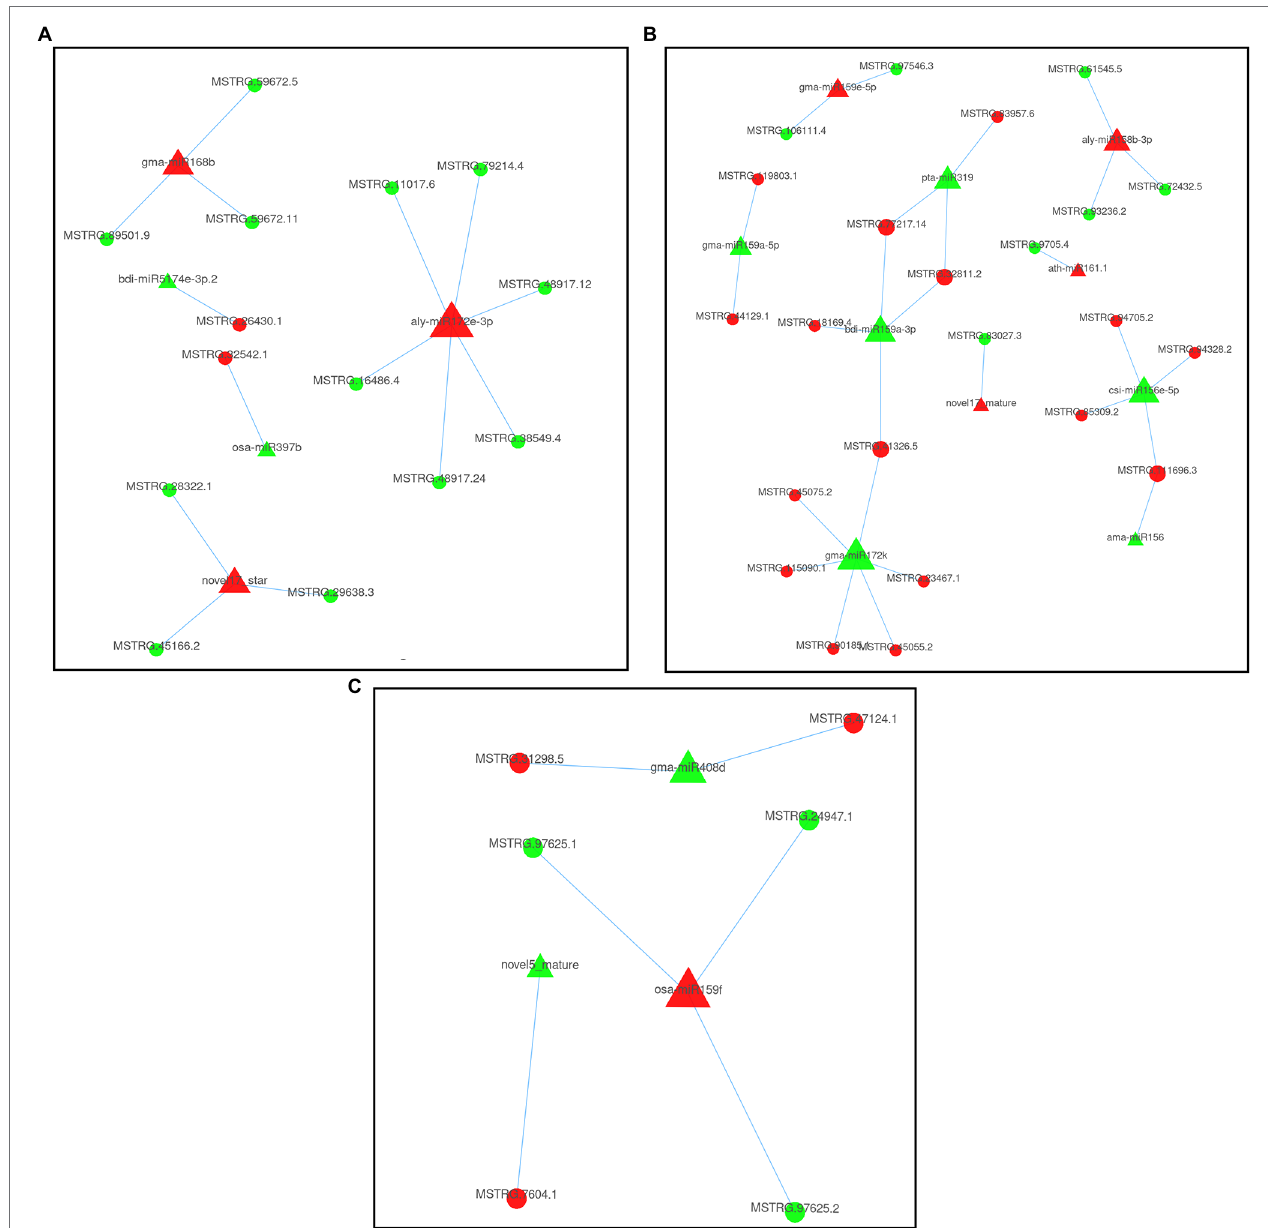
FIGURE 4 | Potential miRNA and mRNA regulatory network of patchouli in response to continuous cropping obstacle. (A) SP_S2 vs. FP_S2; (B) SP_S3 vs. FP_S3; and (C) SP_S4 vs.